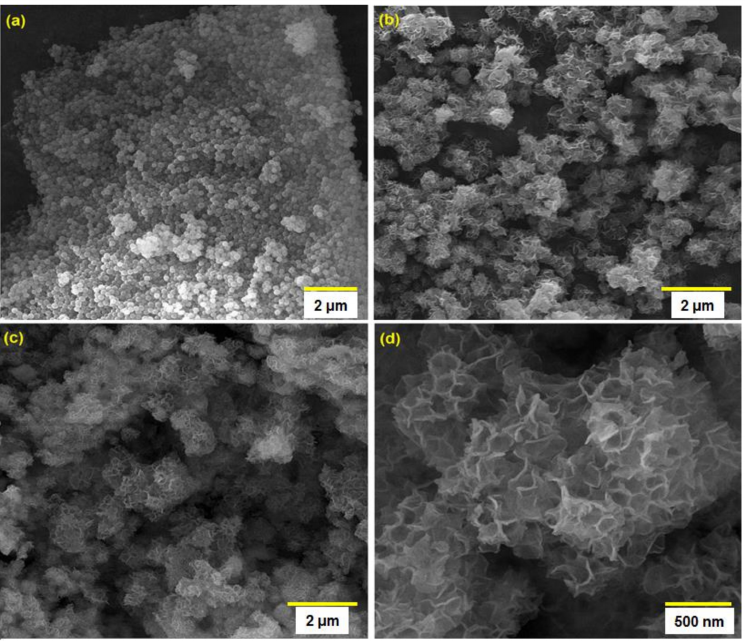
Figure 1. FE-SEM images of SiO 2 spheres ( a ), SiO 2 @Ni-Co LDH core–shell structures ( b ), and Ni-Co LDH hollow structures ( c , d